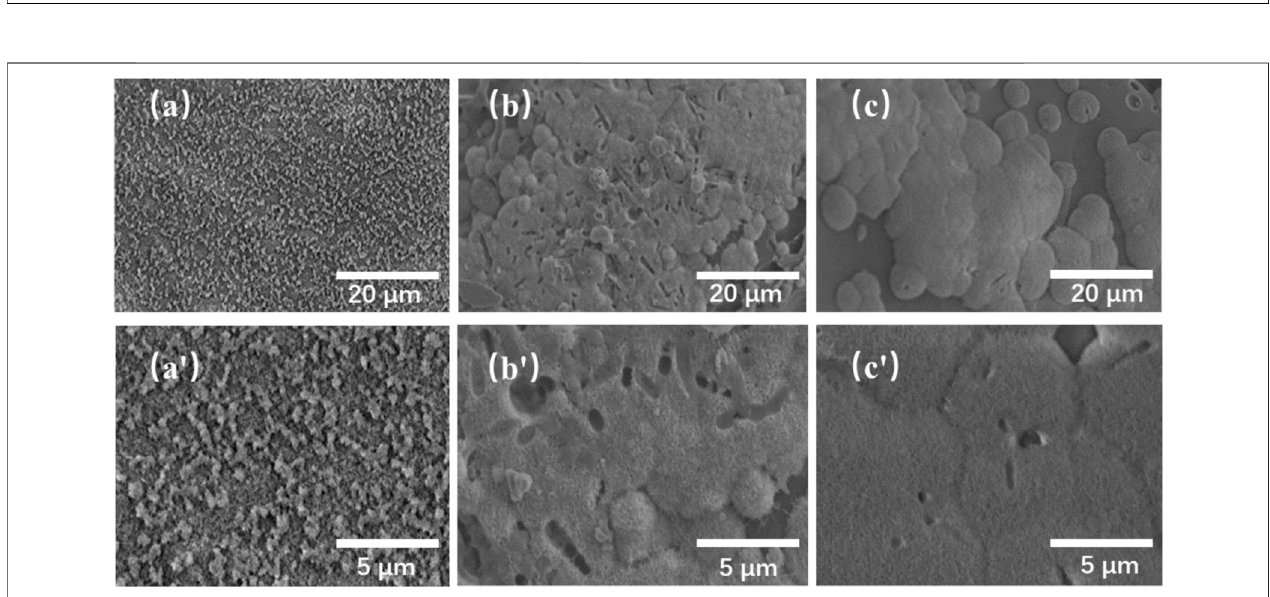
FIGURE 4 | SEM images of the TMBG (A, A 9 ) , TMBG-PDTEC8 (B, B 9 ) , and TMBG-PDTEC16 (C, C 9 ) scaffolds after soaking in SBF for 3 days.